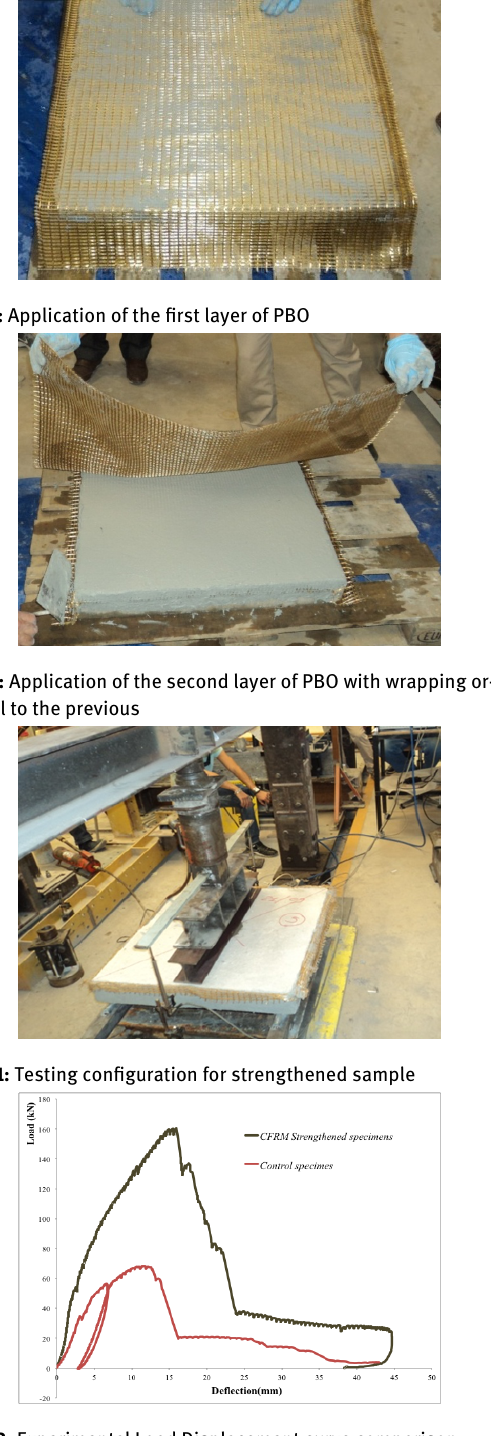
Figure 13: Experimental Load Displacement curve comparison Figure 14: Correlation between the load level and the longitudinal and transversal strain in the FRCM